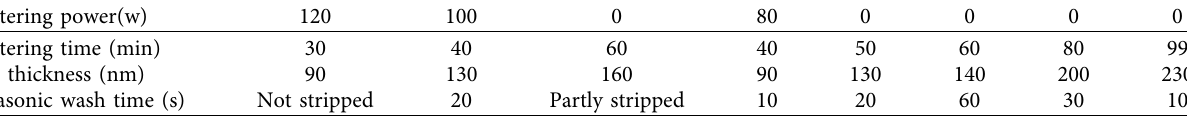
Table 2: Ni film stripping process parameters and thickness.